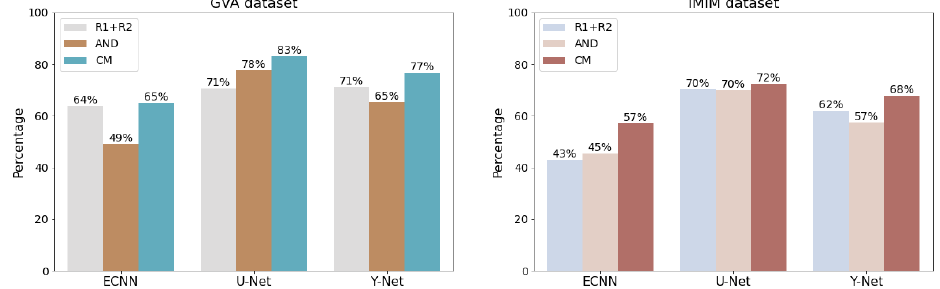
Figure 5. Percent success for each model. A sample in the test set is counted as successful if the Dice score between the estimated mask and the closest radiologist is higher than the concordance between the radiologists (0.77 for GVA and 0.72 for IMIM). The Y-Net includes the parametric and mask